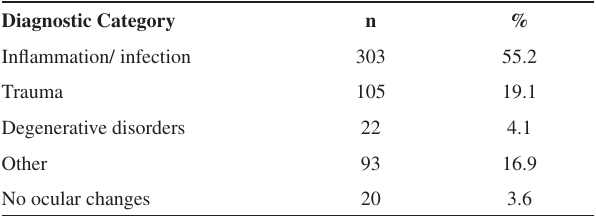
Table 1 – Distribution of patients according to diagnosis at the